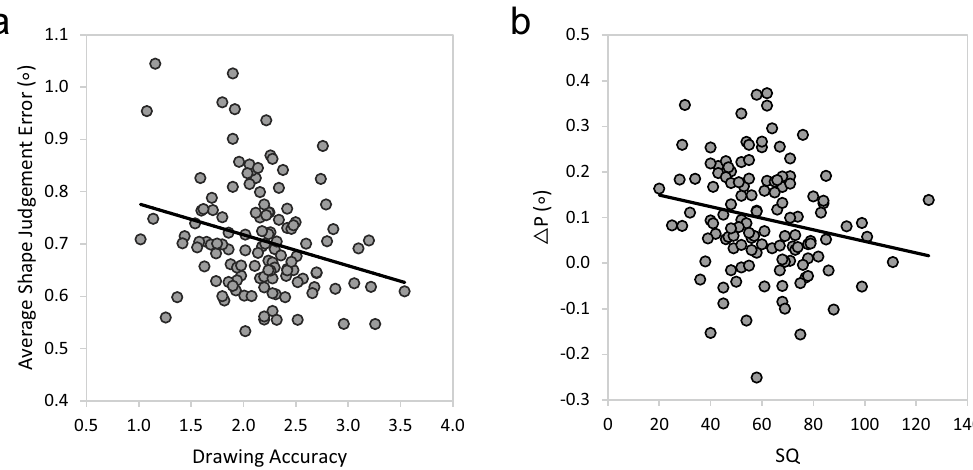
Drawing Accuracy Figure 5. ( a ) Plot of the significant correlation between Average Shape Judgement Error and Realistic Drawing Accuracy. As realistic drawing accuracy increases, average shape judgement error decreases. ( b ) Plot of the significant correlation between two measures of local processing bias—SQ scores and difference scores between projective shape judgement conditions with and without context (ΔP in degrees of visual angle). As SQ scores increase ΔP difference scores